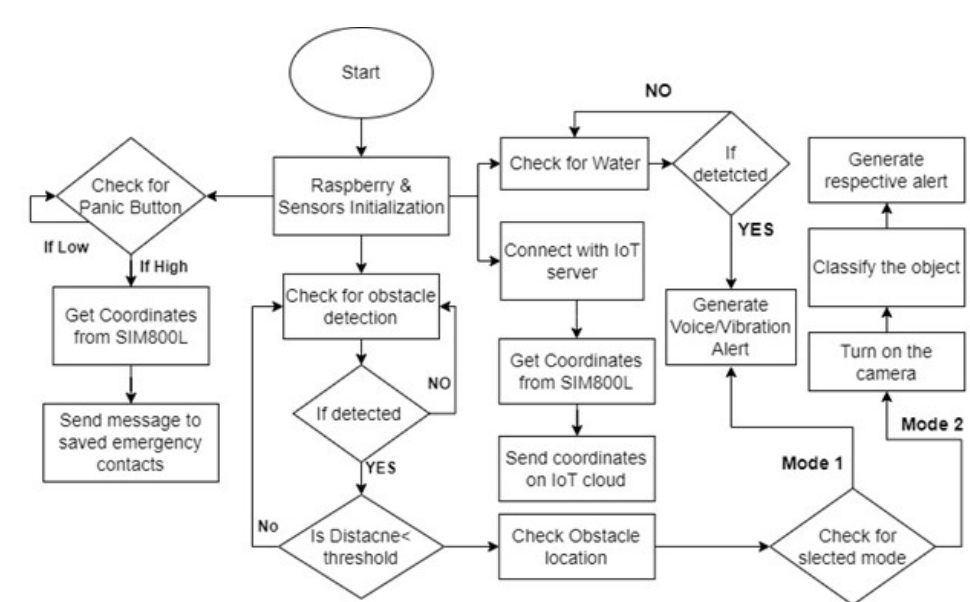
Figure 3. Functional flow diagram of the intelligent stick.